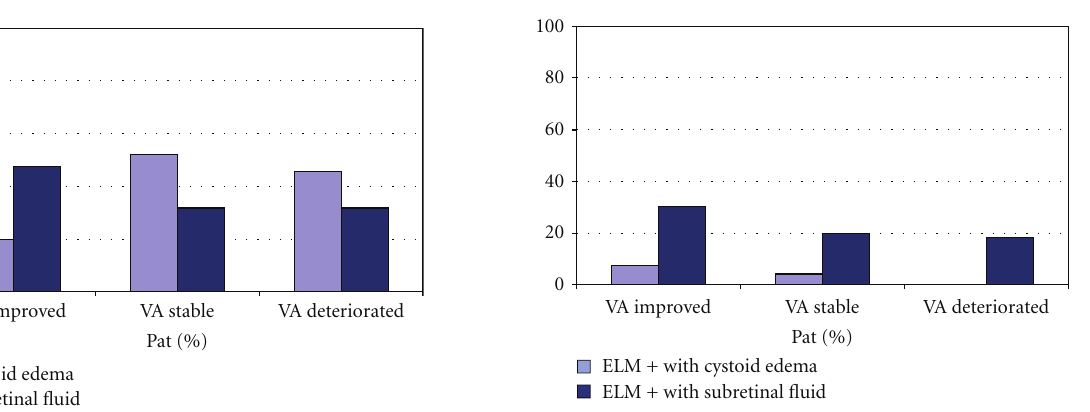
Figure 4: Distribution of patients with intraretinal cystoid edema versus subretinal fluid accumulation in OCT imaging on baseline, in relation to the final visual acuity.